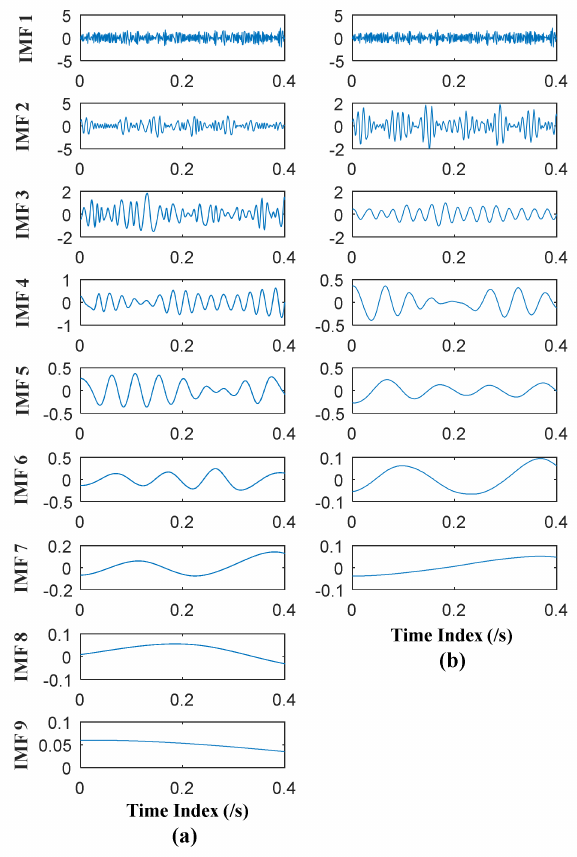
Figure 6. ( a ) Time domain plots of IMFs of EMD; ( b ) Time domain plots of IMFs of